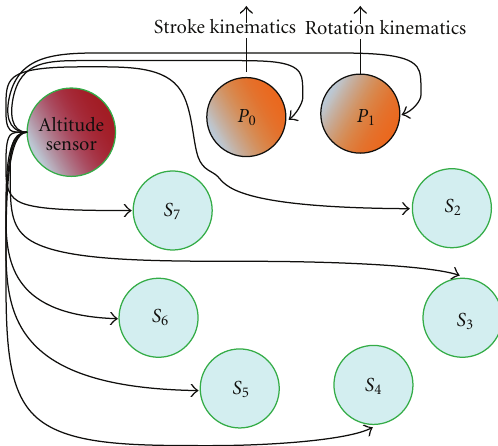
Figure 22: A pictorial representation of the fully connected eight- neuron architecture with a single altitude sensor, of the nonauto- nomous cruise mode controller chosen for qualitative decompo- sition analysis. Following the general neuron representation, the stroke and rotation neurons are marked with “ P ” as primary and “ S ” as secondary for the other neurons and numbered accordingly from 0 to